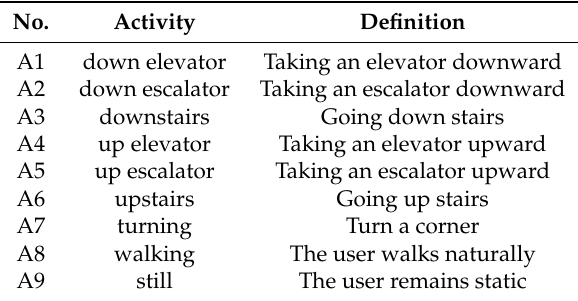
Table 1. Types of activities to classify.